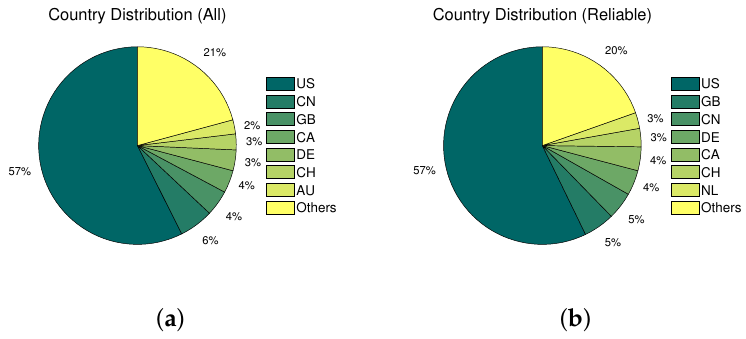
Figure 4. The country distribution of the outstanding scholars. ( a ) The country distribution of all the outstanding scholars. ( b ) The country distribution of outstanding scholars whose author profiles are reliable based on our proposed